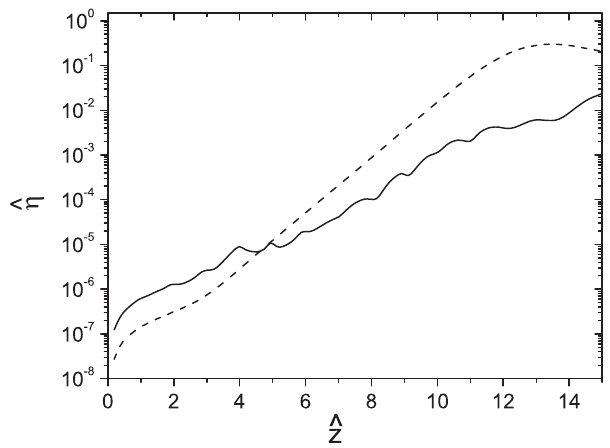
FIG. 10. Normalized power of the fundamental harmonic (solid) and of the third harmonic (dash) versus normalized undulator length. Phase shifts are equal to 4 (cid:1)= 3 at the positions ^ z ¼ 1 ; 2 ; 3 ; 8 ; 9 and 2 (cid:1)= 3 at the positions ^ z ¼ 4 ; 5 ; 6 ; 7 ; 10 ; 11 . The undulator parameter is large, K (cid:6) 1 .